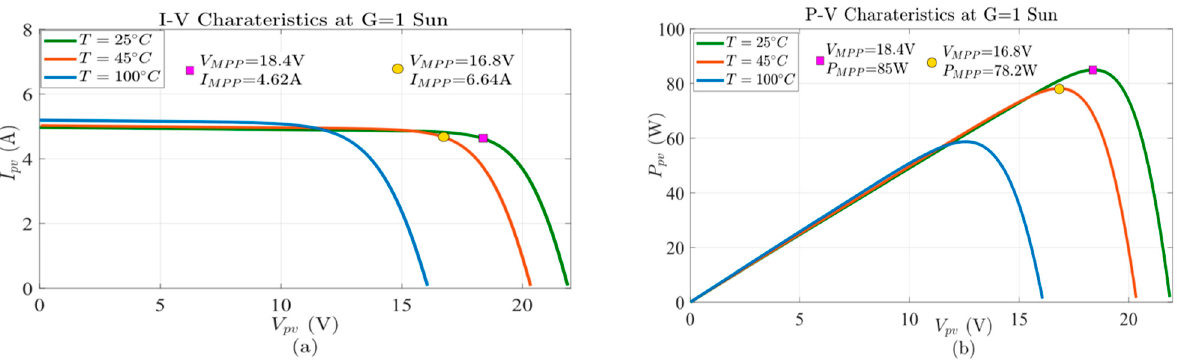
Figure 2. The effect of irradiance changes on the ( a ) I-V and ( b ) P-V characteristics.